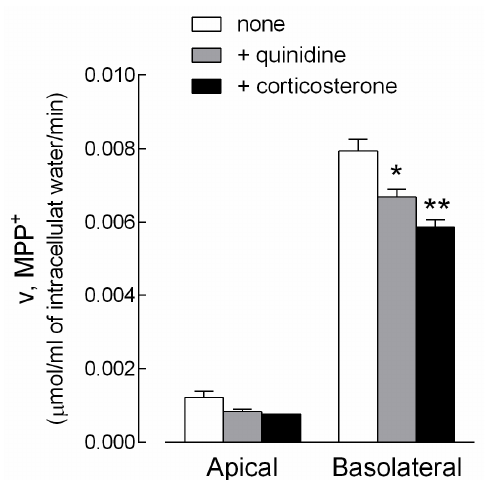
Figure 3. Characterization of MPP + uptake in EpiAirway™. Monolayers of EpiAirway™ were washed with EBSS and incubated for 5 min in the same buffer containing [ 3 H]MPP + (50 μ M; 2 μ Ci/mL), either added to the apical or to the basolateral compartment. Where indicated, quinidine (0.5 mM) or corticosterone (0.5 mM) were present during the transport assay. The intracellular (MPP + ) was determined as described in the Material and Methods Section. Bars represent the mean ± SEM of three independent determinations. * p < 0.05; ** p < 0.01 versus none.